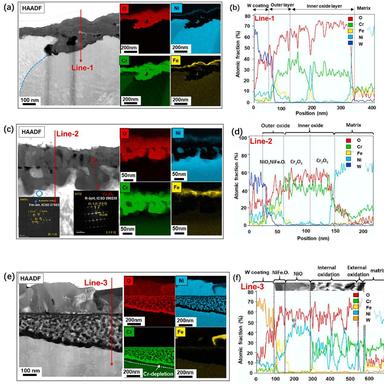
(a) HAADF image and the O, Ni, Cr, Fe element EDS mapping results of the oxide scale formed at the GB (Region A in after exposure in SCW at 600 ◦C for 24 h, illustrating a multi-layer oxide scale, (b) EDS line scan (Line scan 1) across the oxides, (c) the TEM HAADF and the O, Ni, Cr, Fe element EDS mapping results of the thin oxide scale (Region B in, (d) EDS line scan (Line scan 2) across the thin oxide scale, (e) the TEM HAADF and the O, Ni, Cr, Fe element EDS mapping results of th